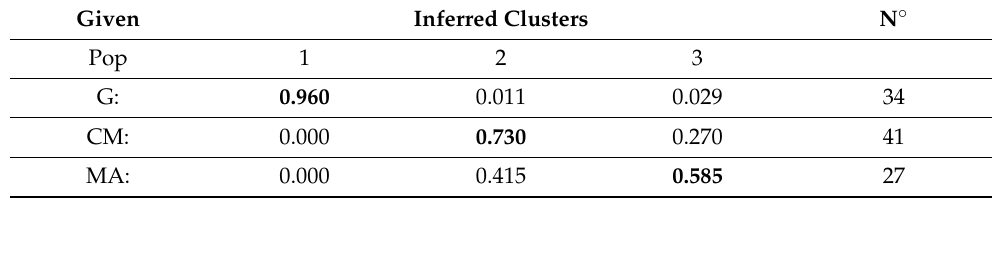
Table 3. Analysis of population structure according to a Bayesian clustering method. The populations studied derive their genetic structure from three inferred gene pools of origin. The proportion of membership of each inferred population in the populations studied is indicated. The main contribution is in bold.